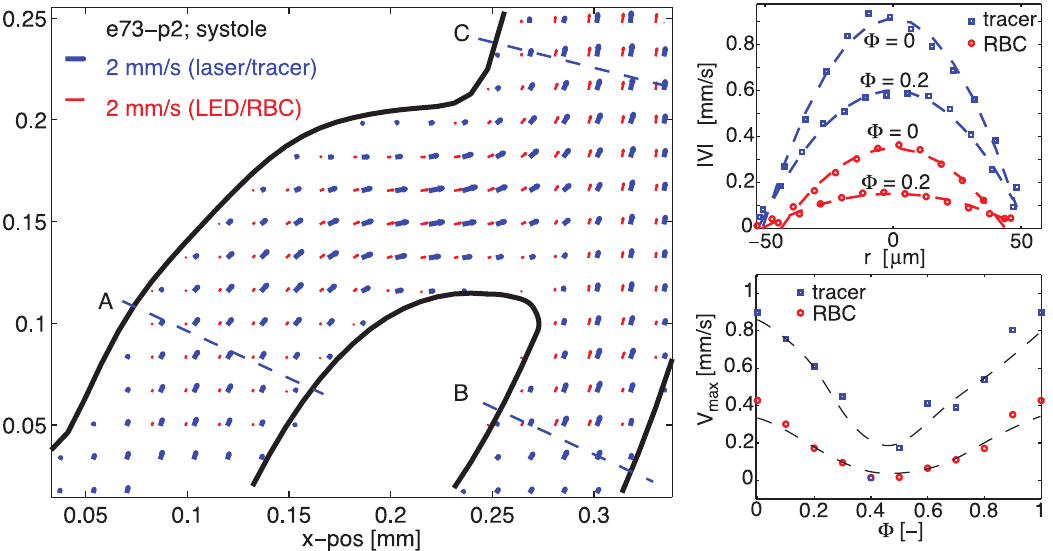
Figure 5. Results obtained at M ~ 25 | . (Left) : Superposition of the vector fields using fluorescent tracers (bold, blue vectors) and red blood cells (red vectors) at systole; a small off-set is used between the vector fields for clarity. (Top right) : velocity magnitude for both methods along profile A for two time steps ( W ~ 0 and W ~ 0 : 2 ). (Bottom right) : Centerline velocity at profile A for during the cardiac cycle for both methods.